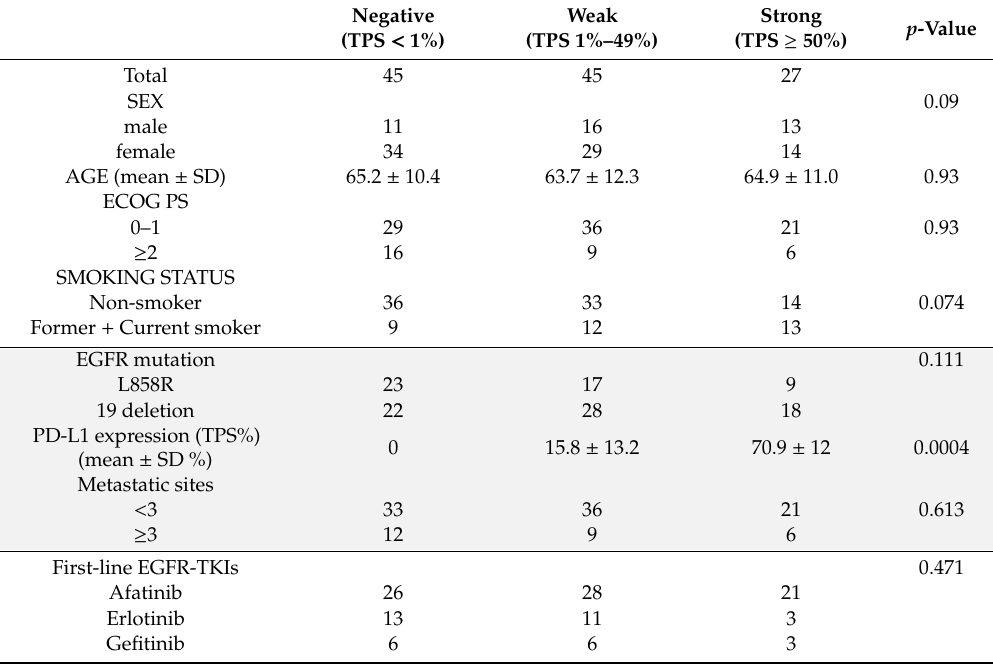
Table 2. Comparison of characteristics between three groups of